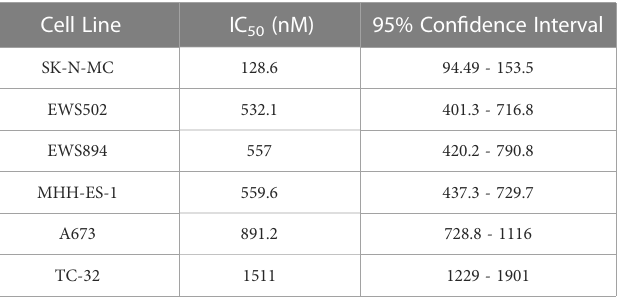
TABLE 4 MS0621 IC 50 Values in Ewing sarcoma Cell